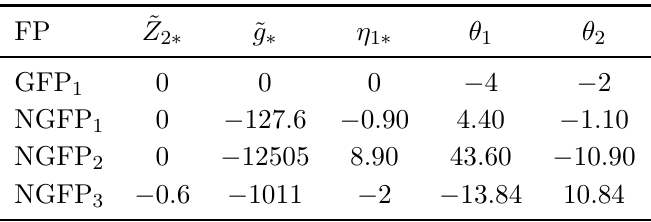
Table 1 . Properties of the finite FPs seen with dimensionful field. The second and third columns give the values of the couplings (2.2); the fourth the anomalous dimension and the last two the scaling